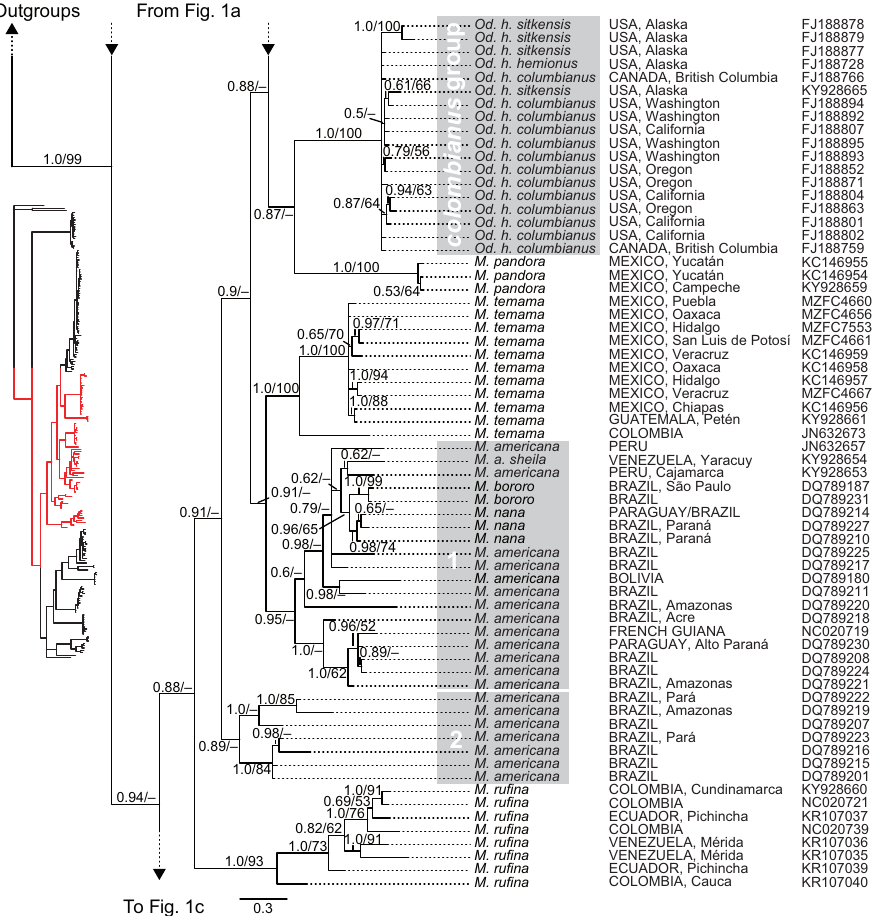
Figure 1b. Phylogenetic tree of cytochrome- b sequences of Odocoileini (continuation). This is a strict consensus topology resulting from the Bayesian inference analysis. Nodal support is indicated at each node, except where the relationship received negligible support. Posterior probabilities (from the Bayes- ian inference analysis) and bootstrap values (from the maximum-likelihood analysis) are indicated before and after the slashes (“/”) at branches of interest (i.e., nodal support for fairly shallow relationships within intraspecific haplogroups are omitted). The scale represents substitutions per site. For each terminal, coun- try of origin and next-largest administrative unit (state, department, province, etc.) are provided (when reported by the team that generated them; see detailed voucher and locality information in supplementary file 1 for sequences that we generated). GenBank accession numbers are indicated for each